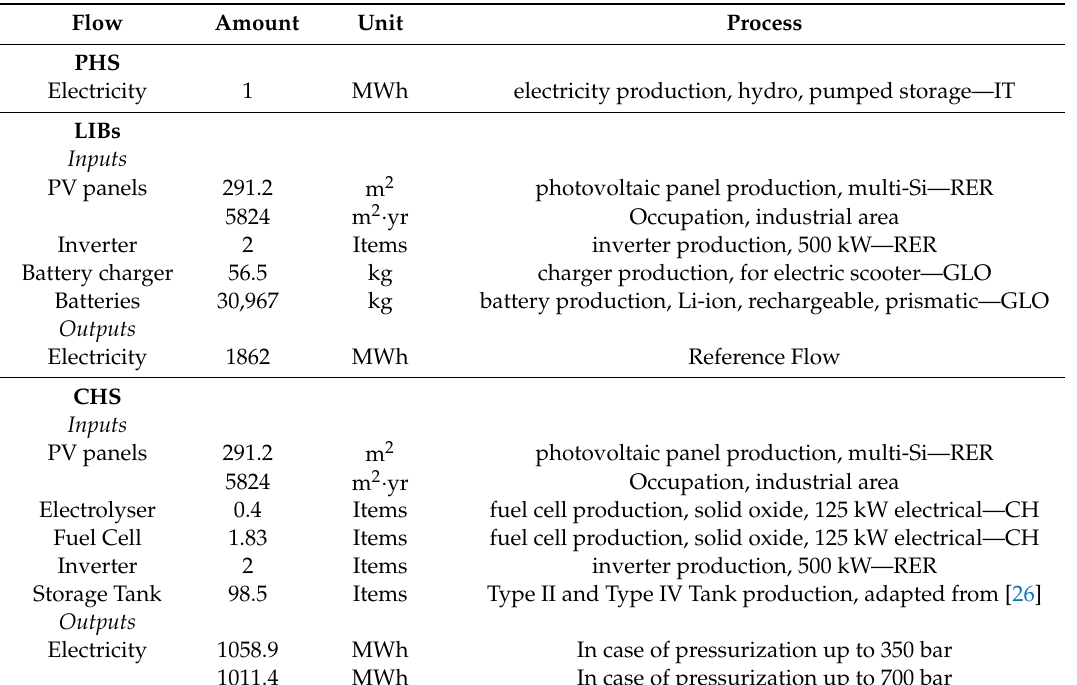
Table 5. Life Cycle Inventory of the PHS, LIBs and